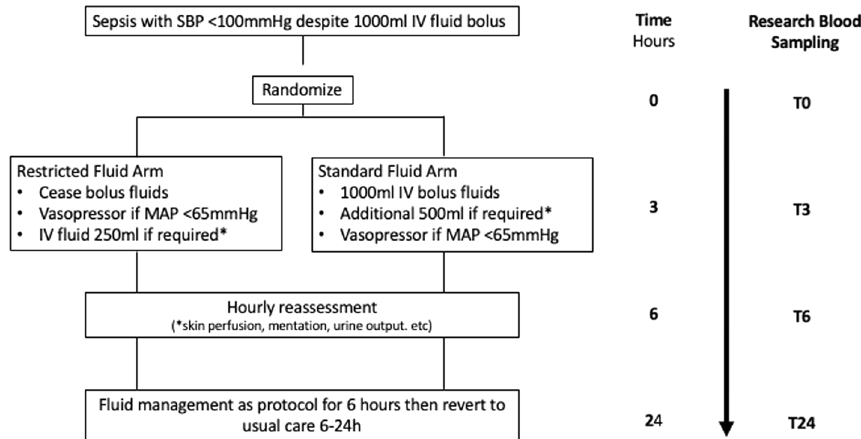
Fig. 1 Flowchart summarising trial